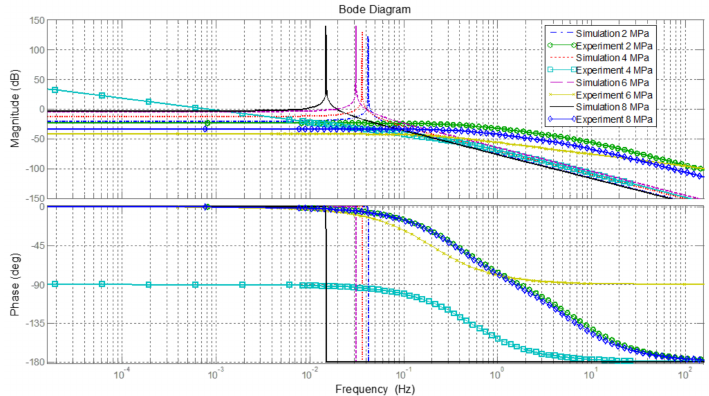
Figure 13. VCM-DHPV frequency response comparison between the simulated and measured